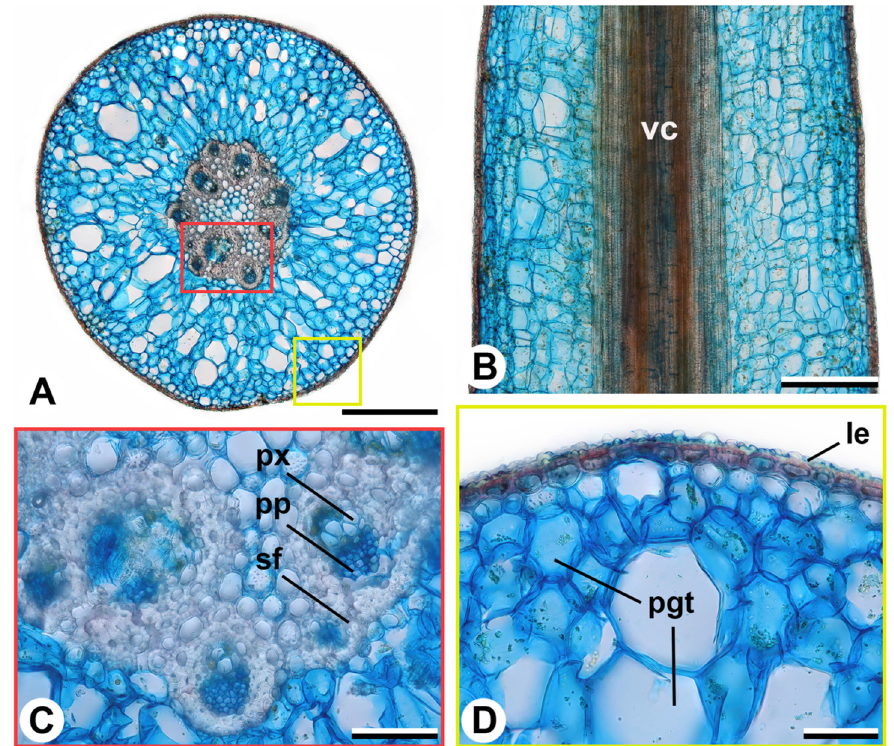
Figure 4. Anatomical structure of the first floral unit of the rachis of C. monilirachis. ( A ) Cross section; ( B ) longitudinal section; ( C ) closed collateral vascular bundles; ( D ) cross section of the peripheral zone with hypertrophied parenchyma cells. Abbreviations: px, primary xylem; pp, primary phloem; sf, sclerenchyma fiber; pgt, parenchymatous ground tissue; le, lignified epidermis; vc, vascular cylinder. Scale bars: ( A,B ) = 0.25 cm; ( C ) = 0.05 mm; ( D ) = 0.04 mm.